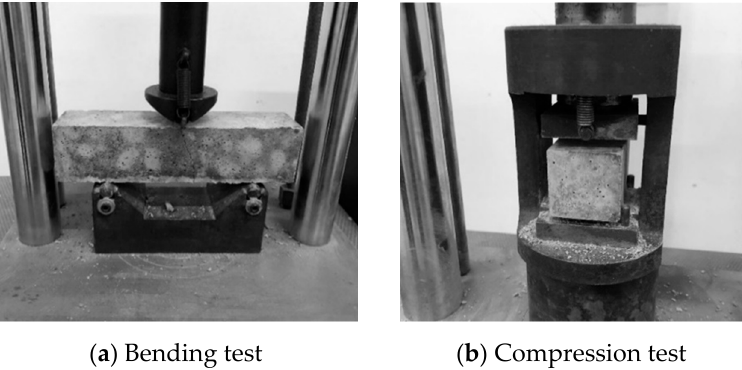
Figure 2. ( a , b ) Experimental setups for bending and compression